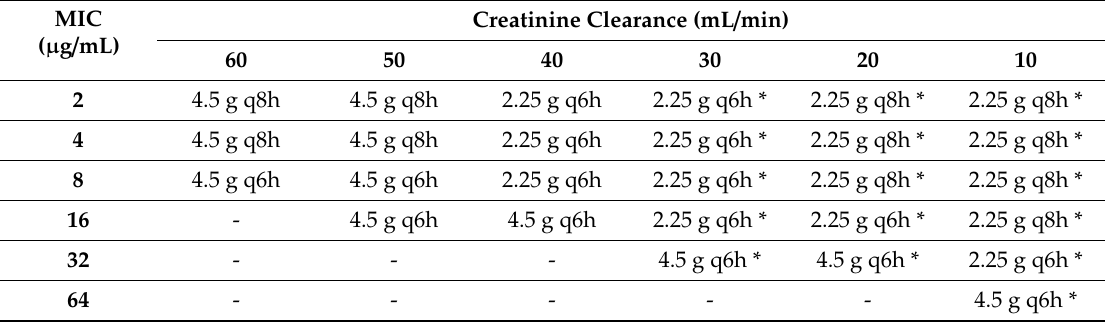
Creatinine Clearance (mL /